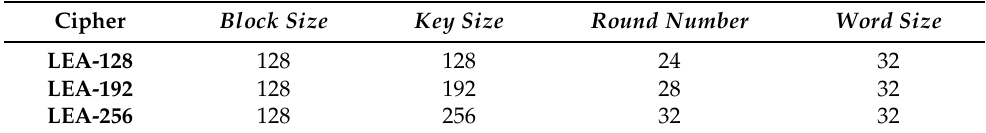
Table 2. Parameters of LEA [1].